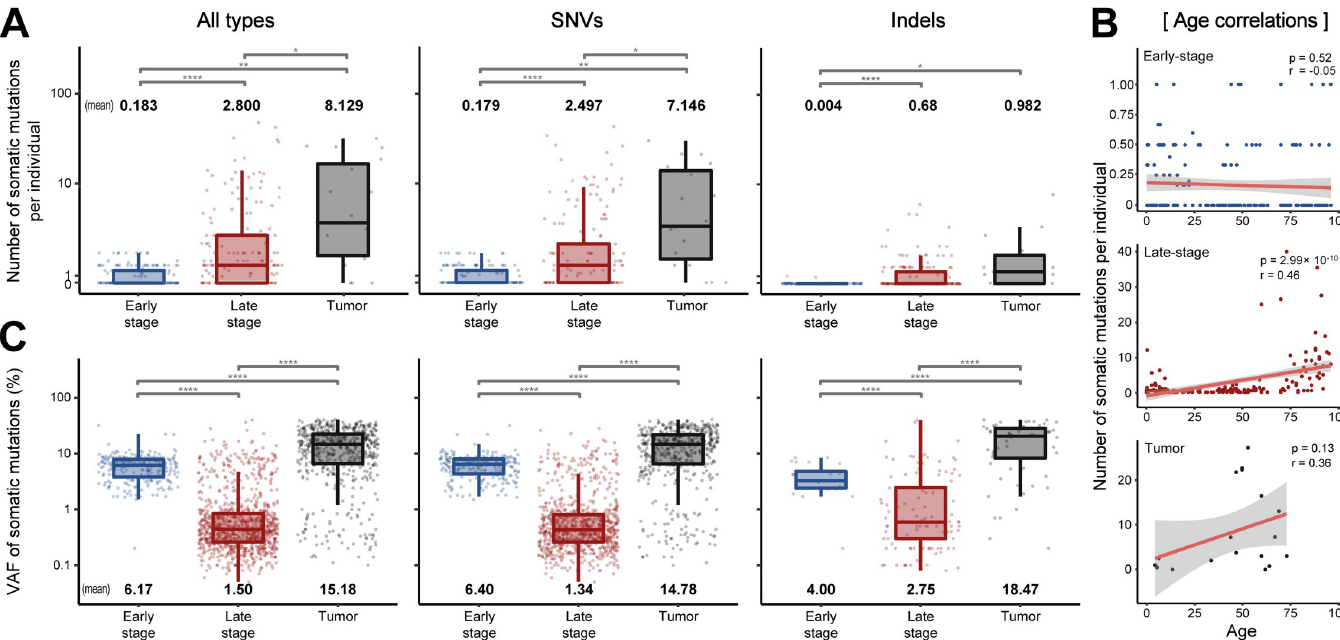
Fig 2. Basic descriptive statistics for somatic mutations. ( A) The number of somatic mutations per individual in the early-stage, late-stage, and tumor mutation groups. ( B) Correlation of age with somatic mutation counts in the groups. ( C) Average VAFs between the three mutation groups.